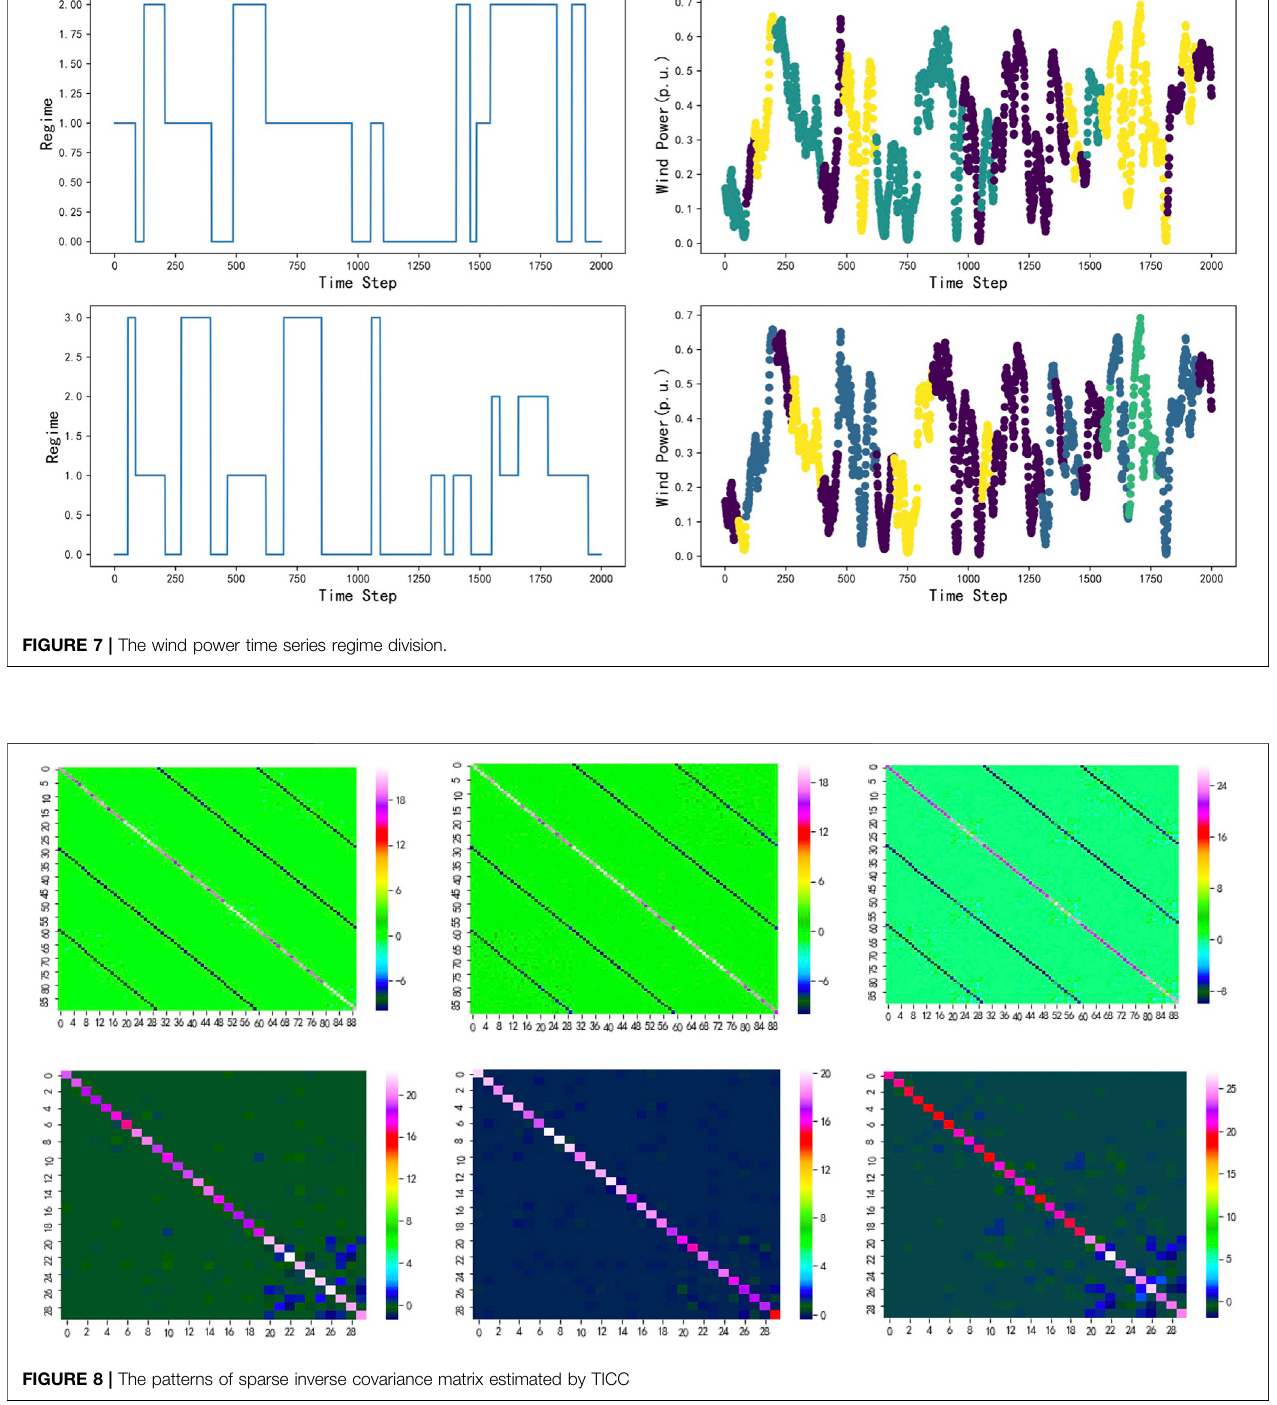
Frontiers in Energy Research |